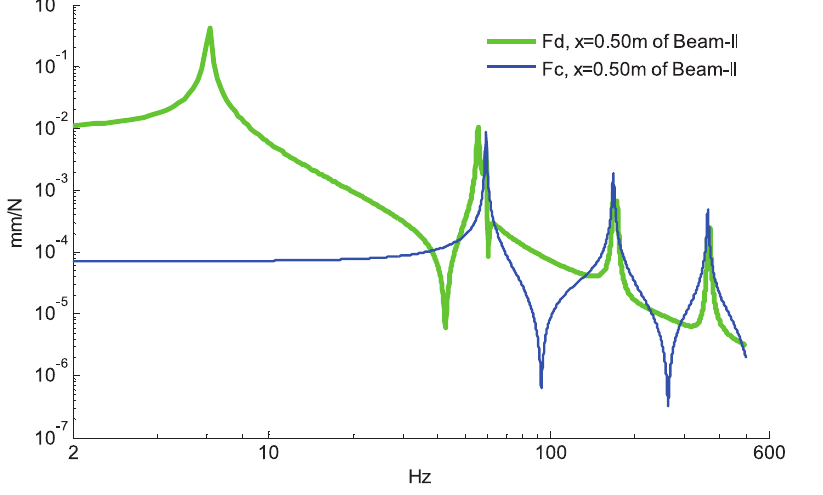
Fig. 5. Magnitude of FRFs (symmetric modes